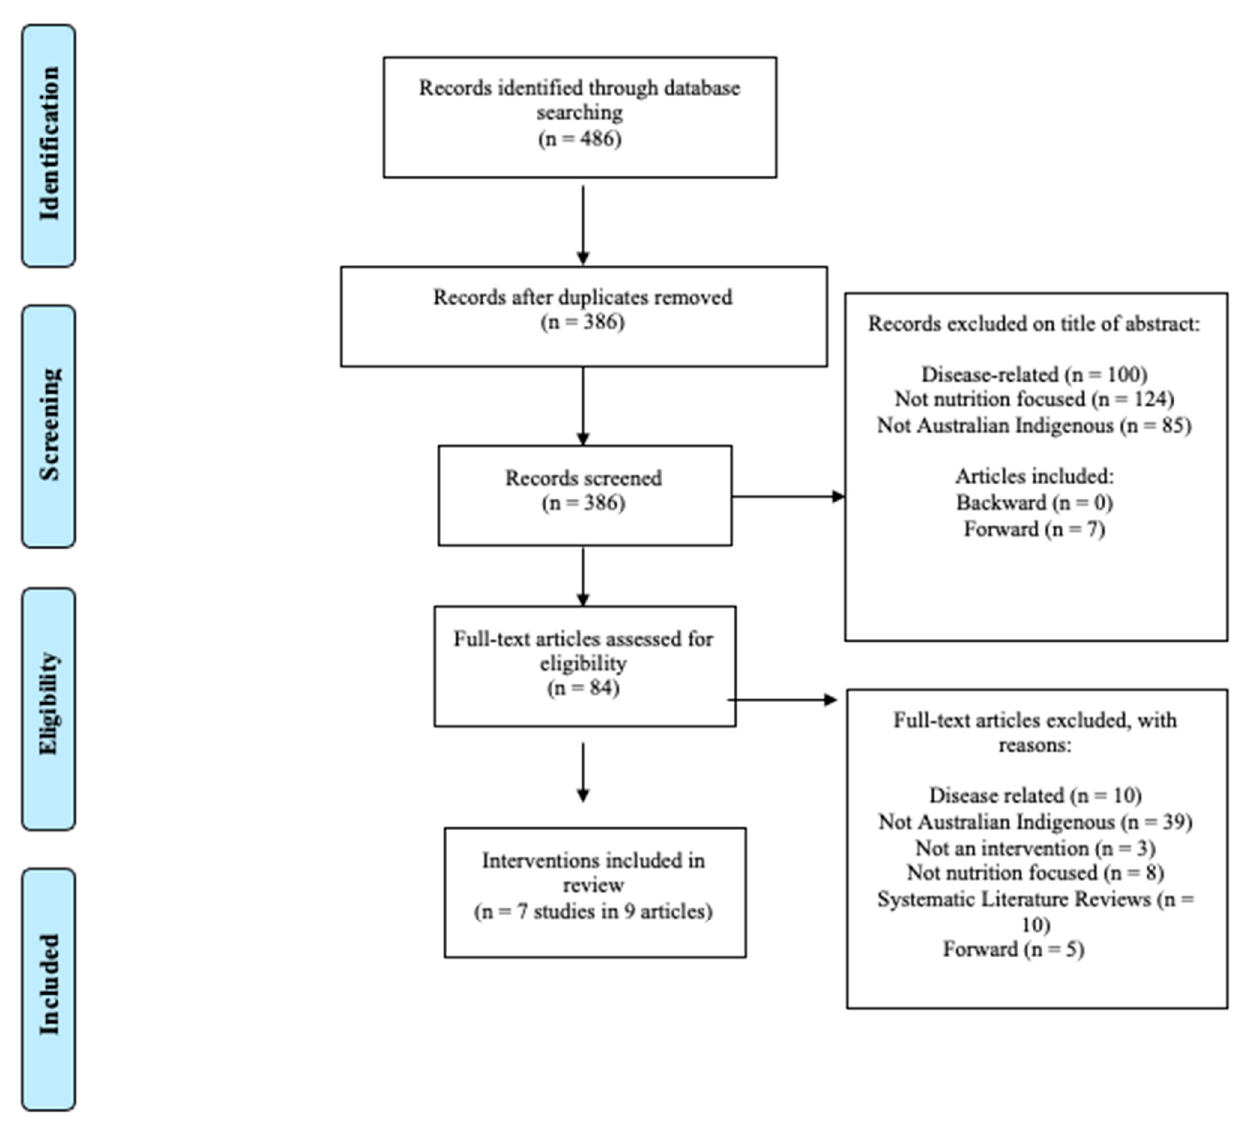
Figure 1. PRISMA 2009 flow diagram.